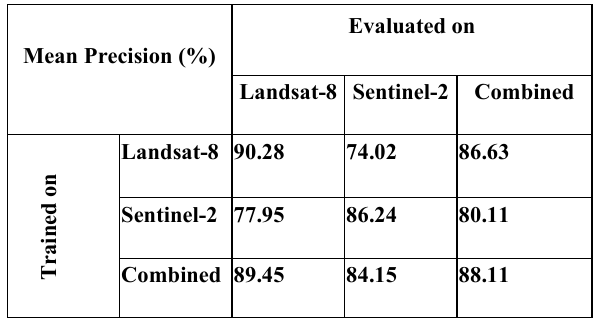
Table 4: Mean precision values on different types of datasets.